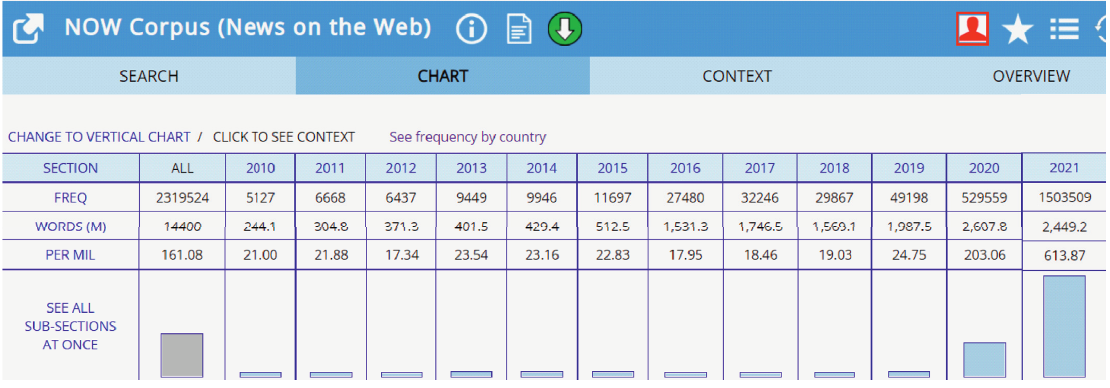
Figure 1: The frequencies of “VACCINE” in NOW Corpus (news on the web) [30].